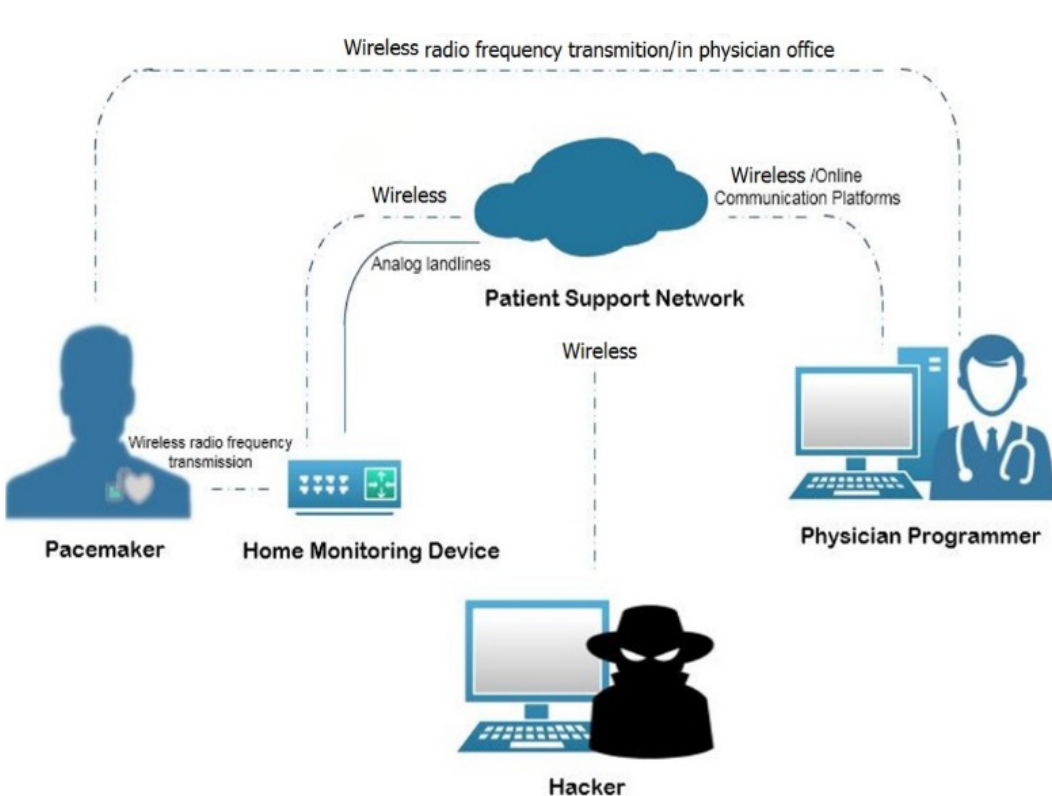
Figure 1. pacemaker automatic remote monitoring system (PARMS).